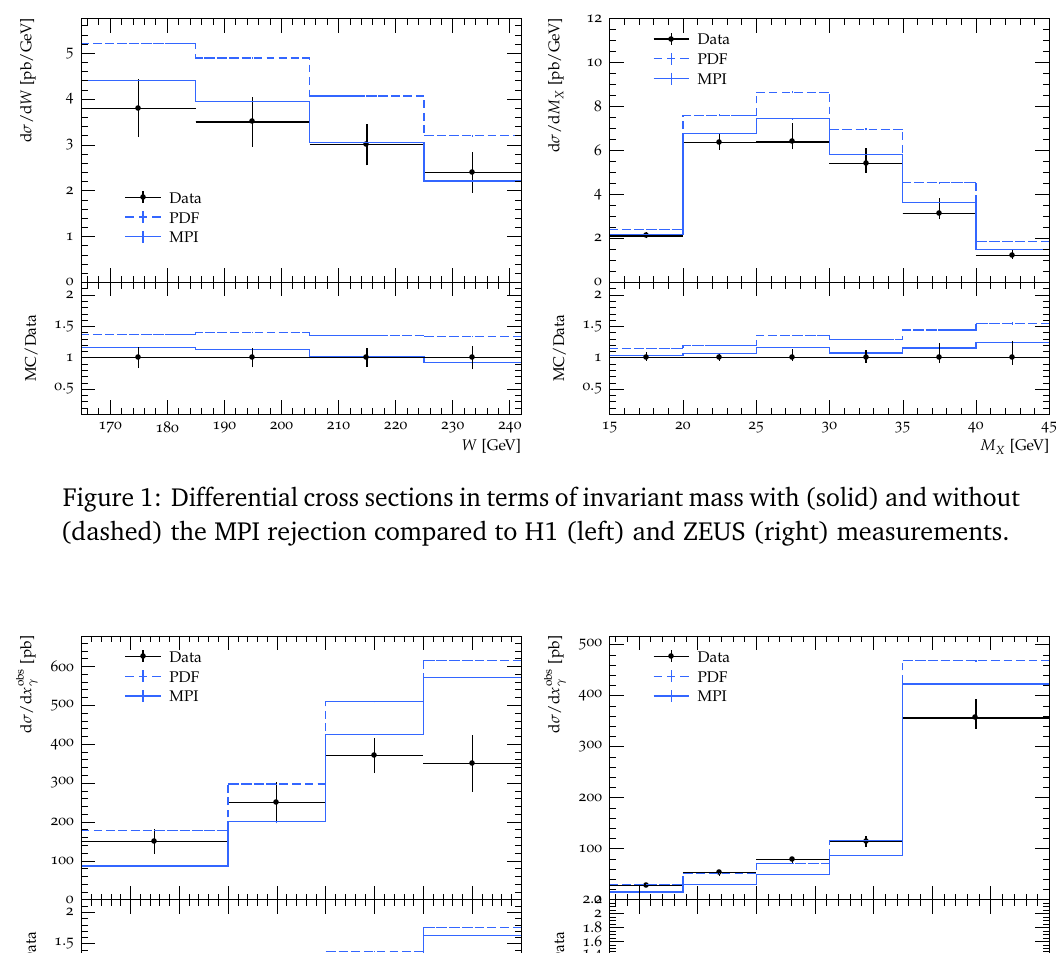
with (solid) and without (dashed) γ